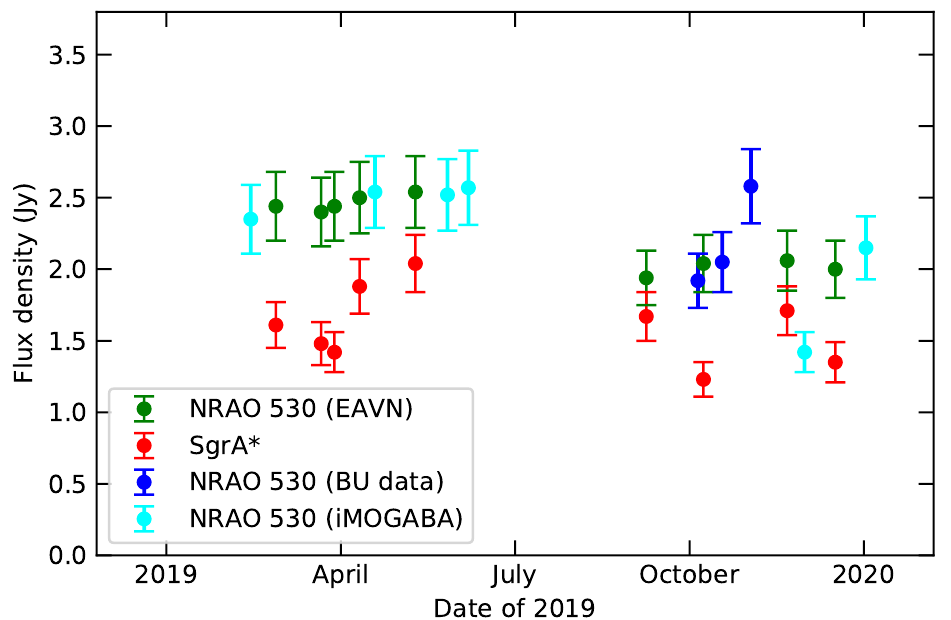
Figure 5. Light curve of SgrA ∗ and NRAO 530 at 43 GHz in 2019. Red points are the flux densities of SgrA ∗ at 43 GHz from our EAVN observations. Other points are flux densities of NRAO 530: green points are from our EAVN observations; blue points are from the BU observations in the second half of 2019; cyan points are from the iMOGABA observations. The error bars are 10% of the total flux